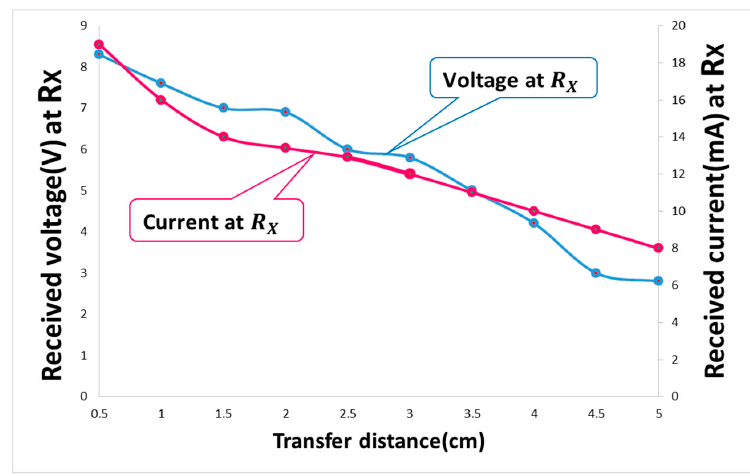
) and in the receiver coil ( 𝑉 (cid:3019) (cid:3273)